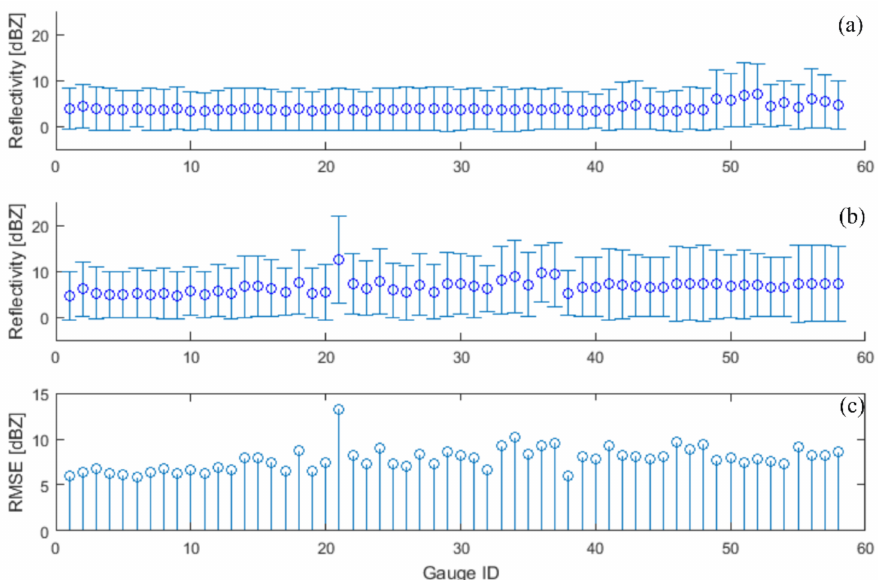
Figure 3. The error-bar plots illustrating reflectivity measured in different gauge locations interpo- lated by the nearest distance ( a ) and the 3D interpolation ( b ), and the performance of ( c ) measured in terms of residual mean square error (RMSE). Horizontal bars indicate the standard error of the